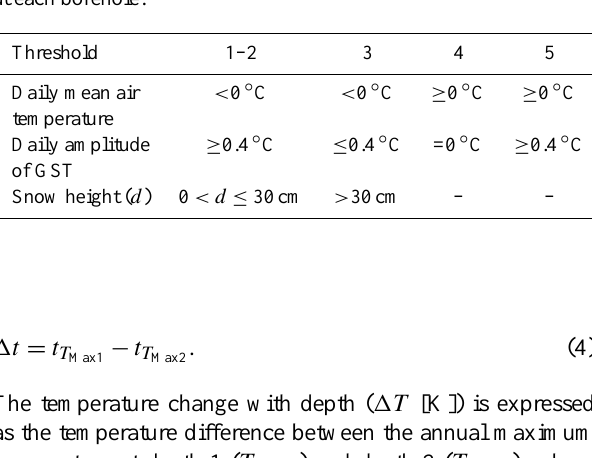
Table 1. Thresholds to differentiate the yearly phases individually at each